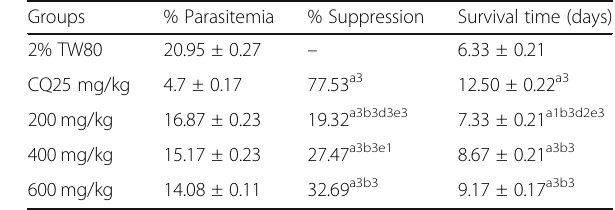
Table 3 Parasitemia and survival time of infected mice treated with 80% methanol extract of the leaves of Olea europaea in Rane ’ s test